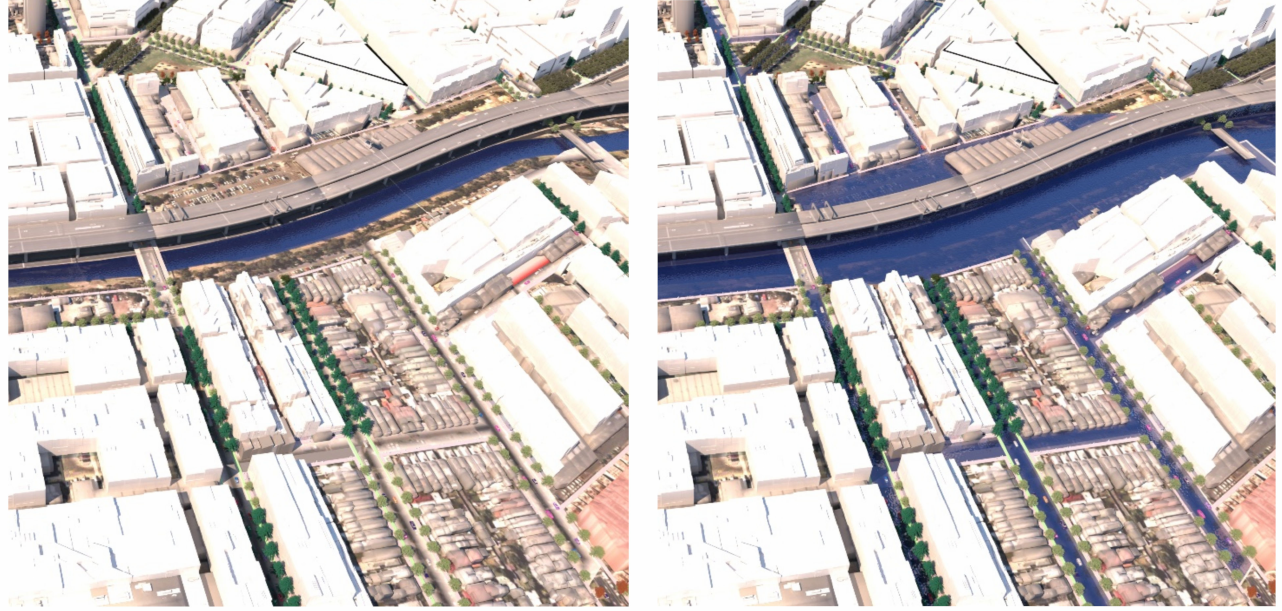
Figure 16. Detail rendering, aerial view looking east for scenario (2) road-based integrated water management LEFT under dry conditions and RIGHT under flood conditions. Image by authors using multi-criteria street tree design decision support modelling approach in Autodesk™ 3ds